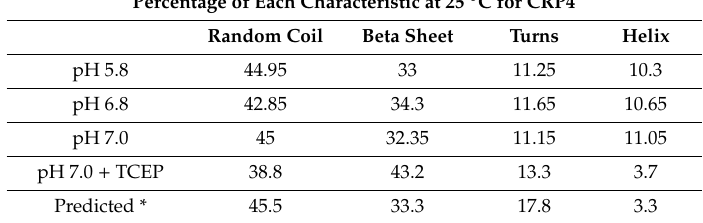
Table 2. Secondary Structure of CRP4 broken down into the four main types of secondary structure identified by DichroWeb. * Predicted percentages were calculated from the 8-state protein secondary structure (SS 8 ) predicted model produced by NetSurfP-2.0, with bend collapsed into random coil structure.